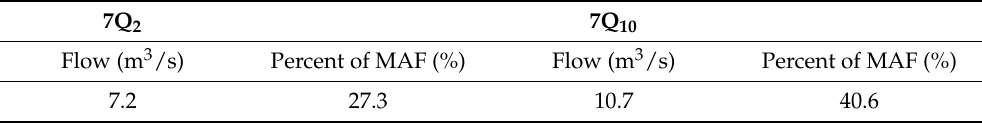
Table 8. Minimum annual 7-day flow with 2 and 10 years return period for the Kor River.